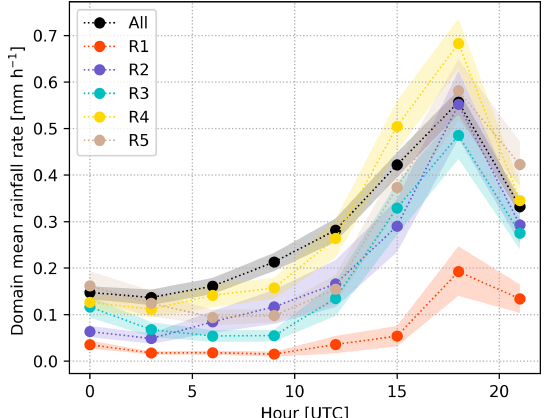
Figure 11. Domain mean precipitation rate (for events with measur- able precipitation) from the SIPAM radar to within a 110km radius of the MAO site. The dotted lines report the dataset mean values, and the shading is 1 σ standard